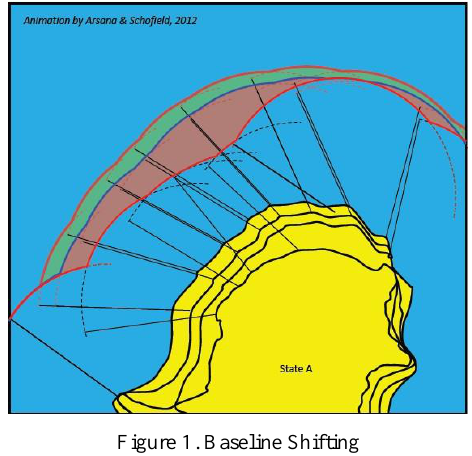
Figure 1. Baseline Shifting